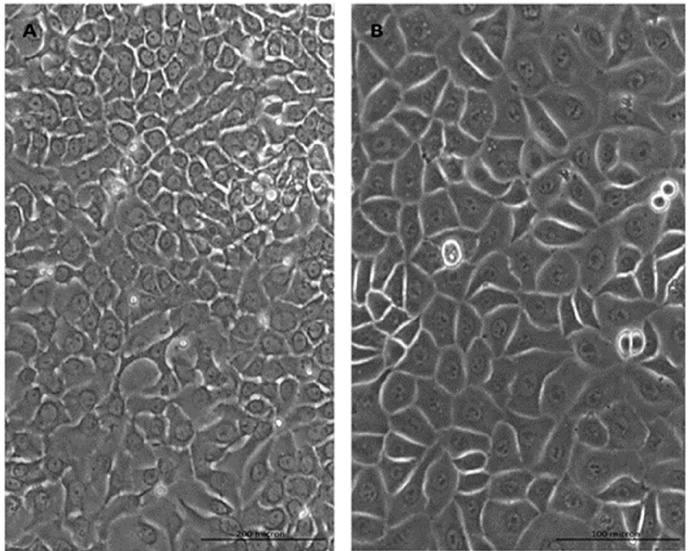
Figure 1. Monolayer human respiratory epithelial cells (RECs) cultured in a 6-well plate. Presented RECs were obtained from a co-culture of RECs and human fibroblasts and at passage 1, the cells showed polygonal morphology. ( A , B ) show 100× and 200× magnifications, respectively.